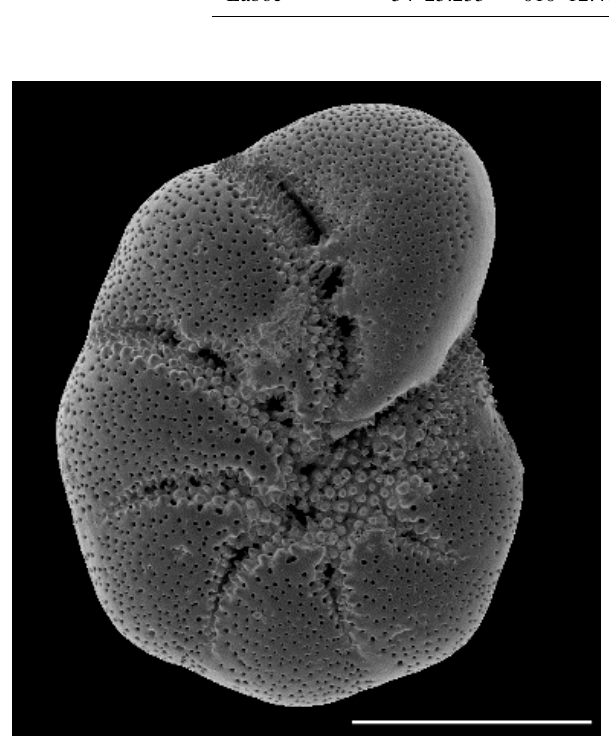
Figure 1. SEM (scanning electron microscope) picture of the incu- bated foraminifera E. excavatum S5 after Darling et al. (2016). Bar scale is